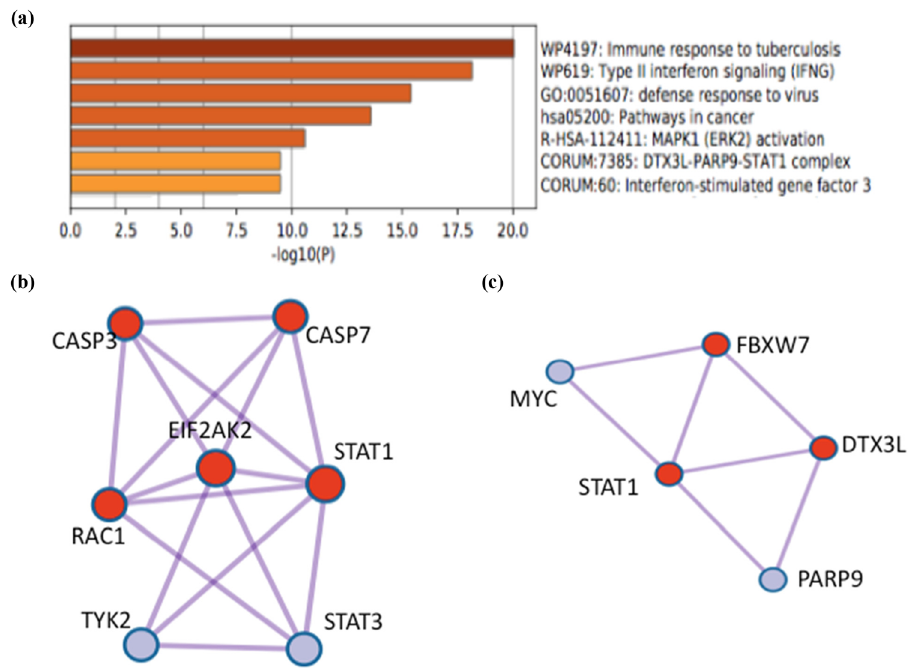
Figure 10: GO terms associated with the PIC - Venn network and novel modules in type I interferon signaling. ( a ) Biological functions and GO terms associated with PIC - Venn network of type I interferon signaling are ranked by signi fi cance. ( b ) Network analysis of common protein interaction partners of signaling hubs STAT1 and EIF2AK2 ( PKR ) involved in bacterial and double - stranded RNA signaling. ( c ) Novel module involving STAT1 - DTX3L and PARP - 9 involved in